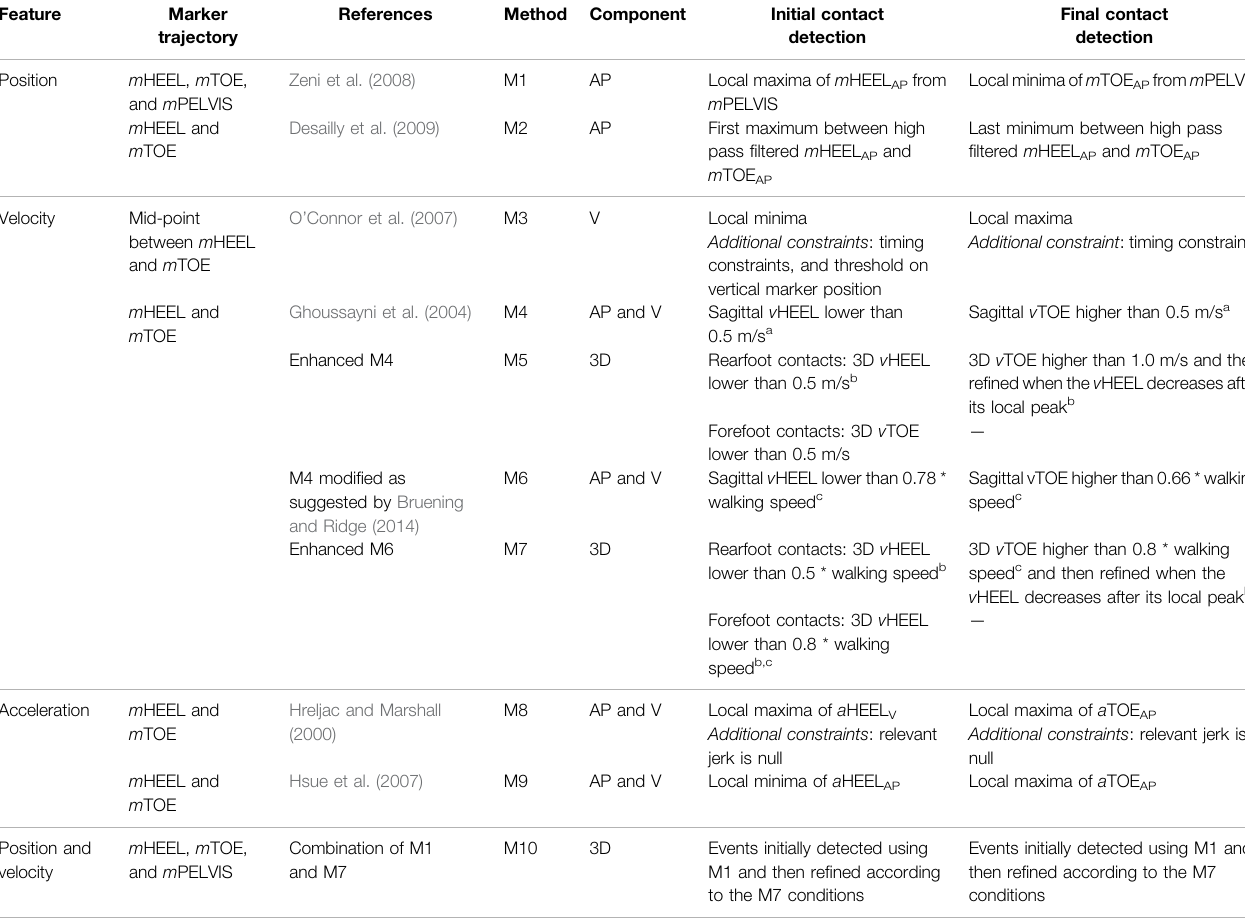
TABLE 1 | Outline of the gait event identi fi cation methods adopted in this study.